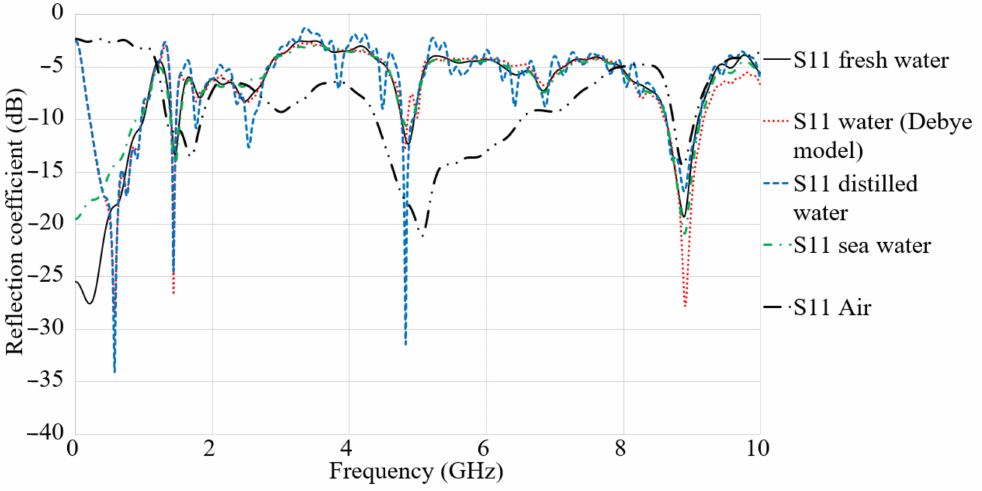
Figure 8. Simulated S 11 results in air, fresh water, water (Debye model), sea water, and distilled water. Figure 9 depicts the simulated S 21 results in air, fresh water, water (Debye model), and distilled water.